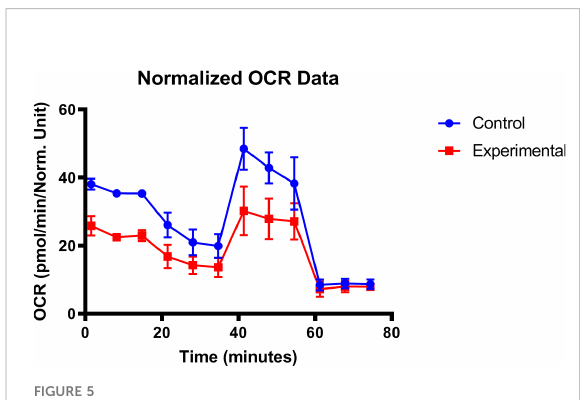
FIGURE 5 Mitochondrial dysfunction in diabetic lacrimal gland. Lacrimal gland cells from the diabetic mice after 16 weeks were evaluated with the seahorse XFp analyzer (ref.